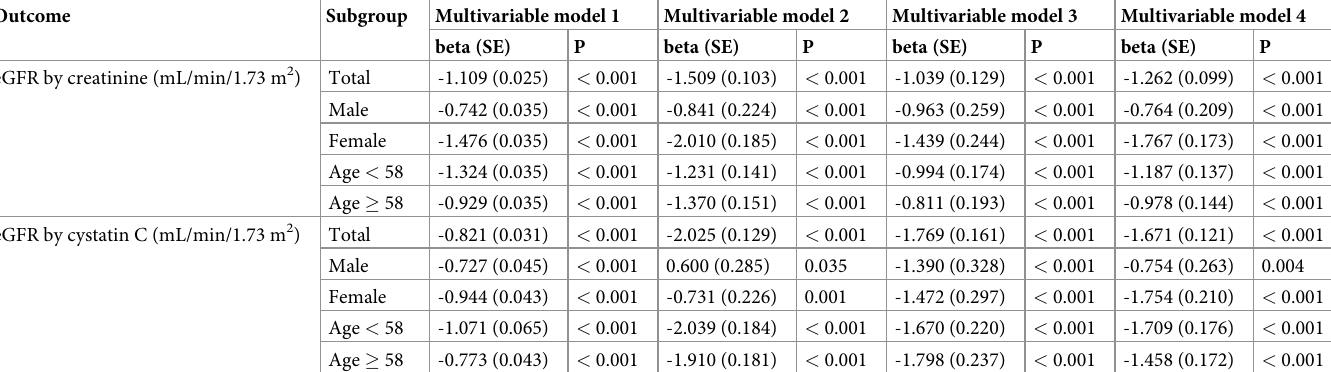
Table 2. Cross-sectional association between adult height (1 standard deviation increase) and estimated kidney function in the UK Biobank cohort. Outcome eGFR by creatinine (mL/min/1.73 m 2